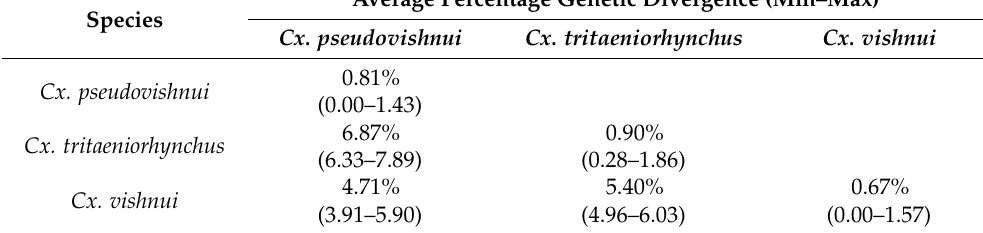
Table 4. Inter- and intraspecific genetic divergence between Cx. pseudovishnui , Cx. tritaeniorhynchus , and Cx. vishnui based on the Kimura two parameter